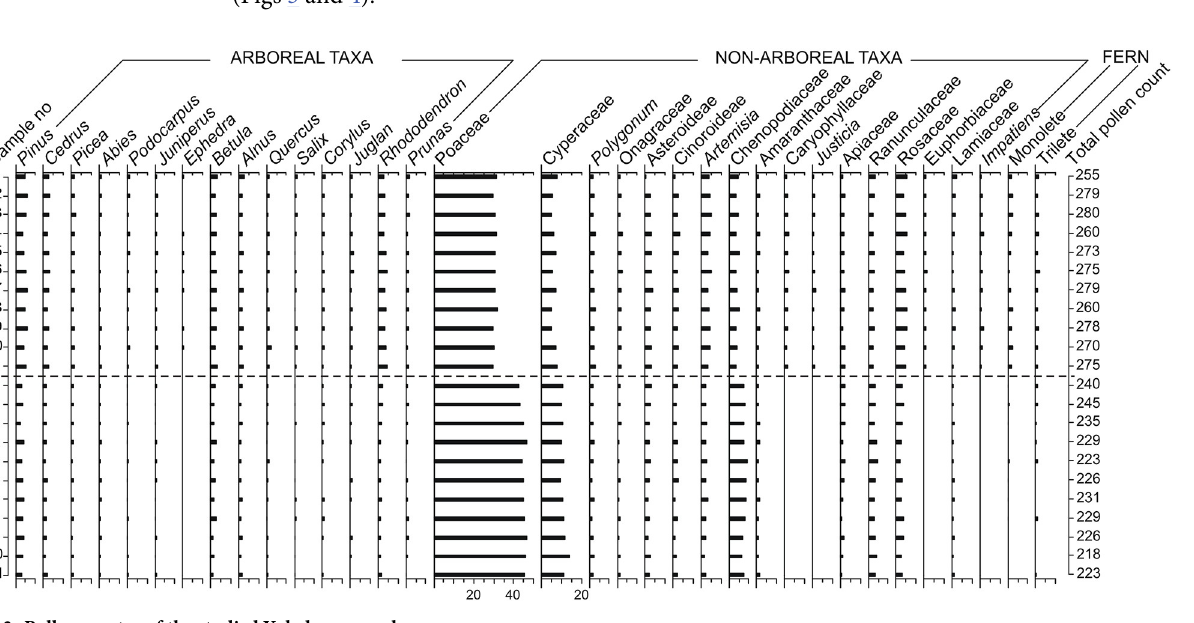
Fig 3. Pollen spectra of the studied Yak dung